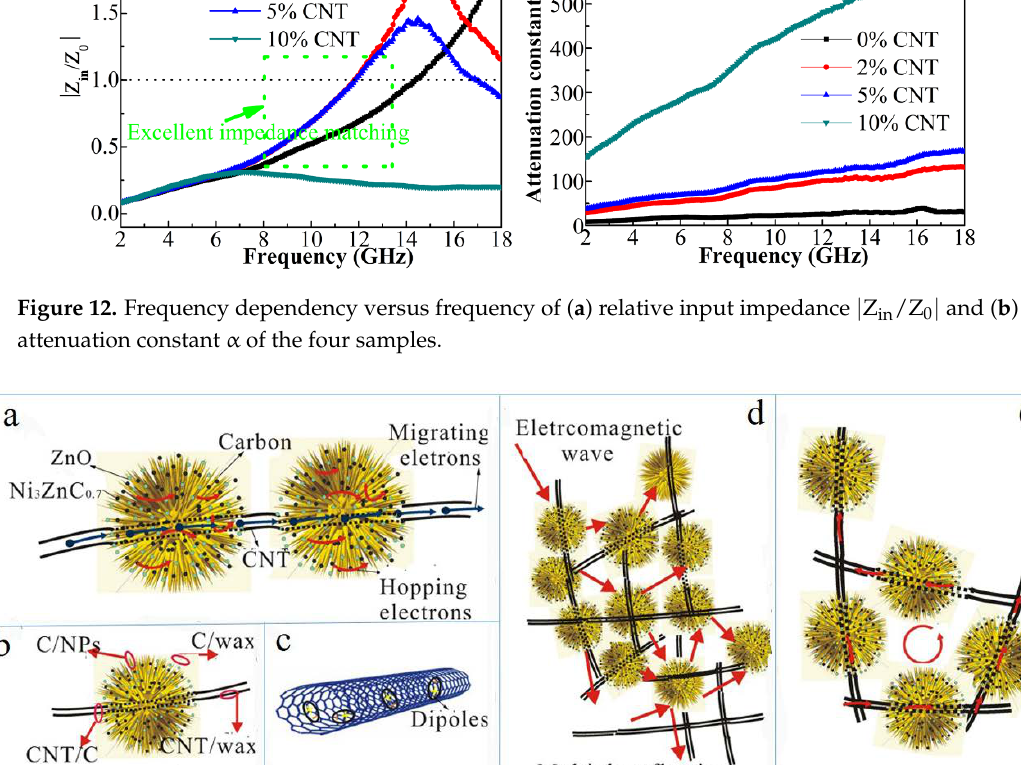
Figure 13. The pattern of electromagnetic wave attenuation models of the composites ( a ) hopping electrons ( b ) interfacial polarization ( c ) dipole polarization ( d ) multiple reflection and scattering ( e ) micro-current in the network.